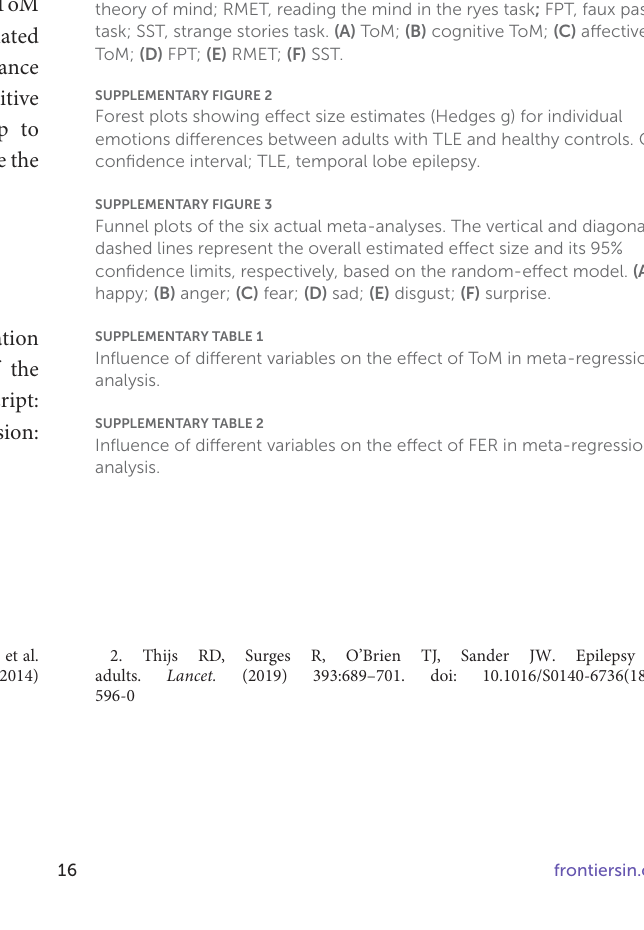
SUPPLEMENTARYTABLE1 Influence of different variables on the effect of ToM in meta-regression analysis. SUPPLEMENTARYTABLE2 Influence of different variables on the effect of FER in meta-regression